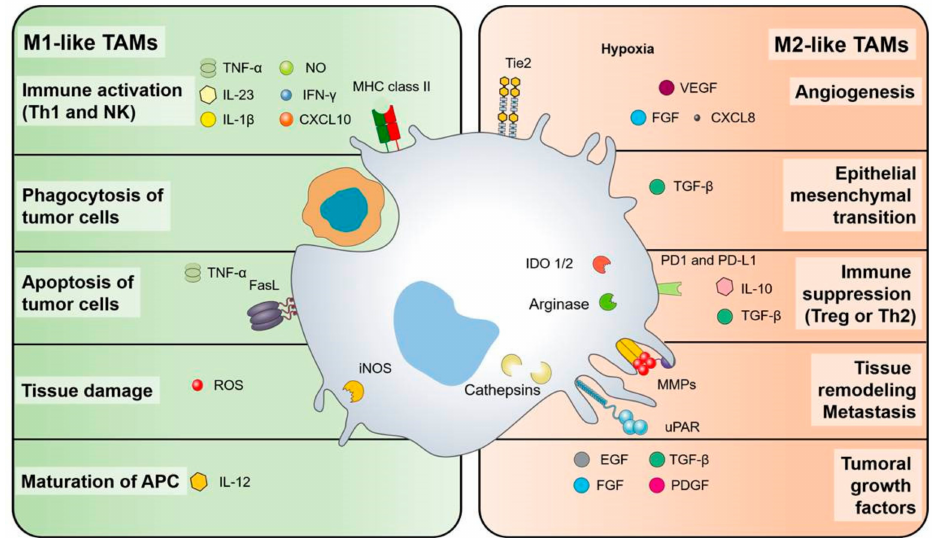
Figure 1. Anti-tumor and pro-tumor functions of tumor-associated macrophages (TAMs). A key feature of macrophages is their intrinsic plasticity, the two extremes of which have been identified as M1-like and M2-likepolarization. Inthetumormicroenvironment, severalmolecularpathwayshavebeenrecognized which drive and maintain the phenotypes and functions of TAMs. On the left side, M1-like macrophages, with anti-tumor functions, can be stimulated by immunostimulatory cytokines such as IL-1b, IL-12, IL-23, TNF-alfa, and IFN γ ; MHCII molecules and IL-12 are required for e ffi cient antigen presentation. M1-like TAMs produce chemokines, such as CXCL10, that promotes the recruitment and activation of T cells. In addition, M1-like-TAMs actively phagocytose tumor cells and release TNF-alfa, ROS, and NO for the direct killing of cancer cells. On the right, M2-like macrophages, with pro-tumor functions, are conditioned by the hypoxic tumor micro-environment and by immuno-suppressive mediators (IL-10, TGF β ). M2-like-TAMs secrete molecules to promote angiogenesis (CXCL8, VEGF), tumor proliferation (EGF, FGF, PDGF), induce epithelial-mesenchymal-transition (TGF β ), and continuous matrix remodeling (MMPs, cathepsins, uPAR). Several immuno-suppressive molecules are produced (IL-10, TGF β , IDO1 / 2), which support regulatory T